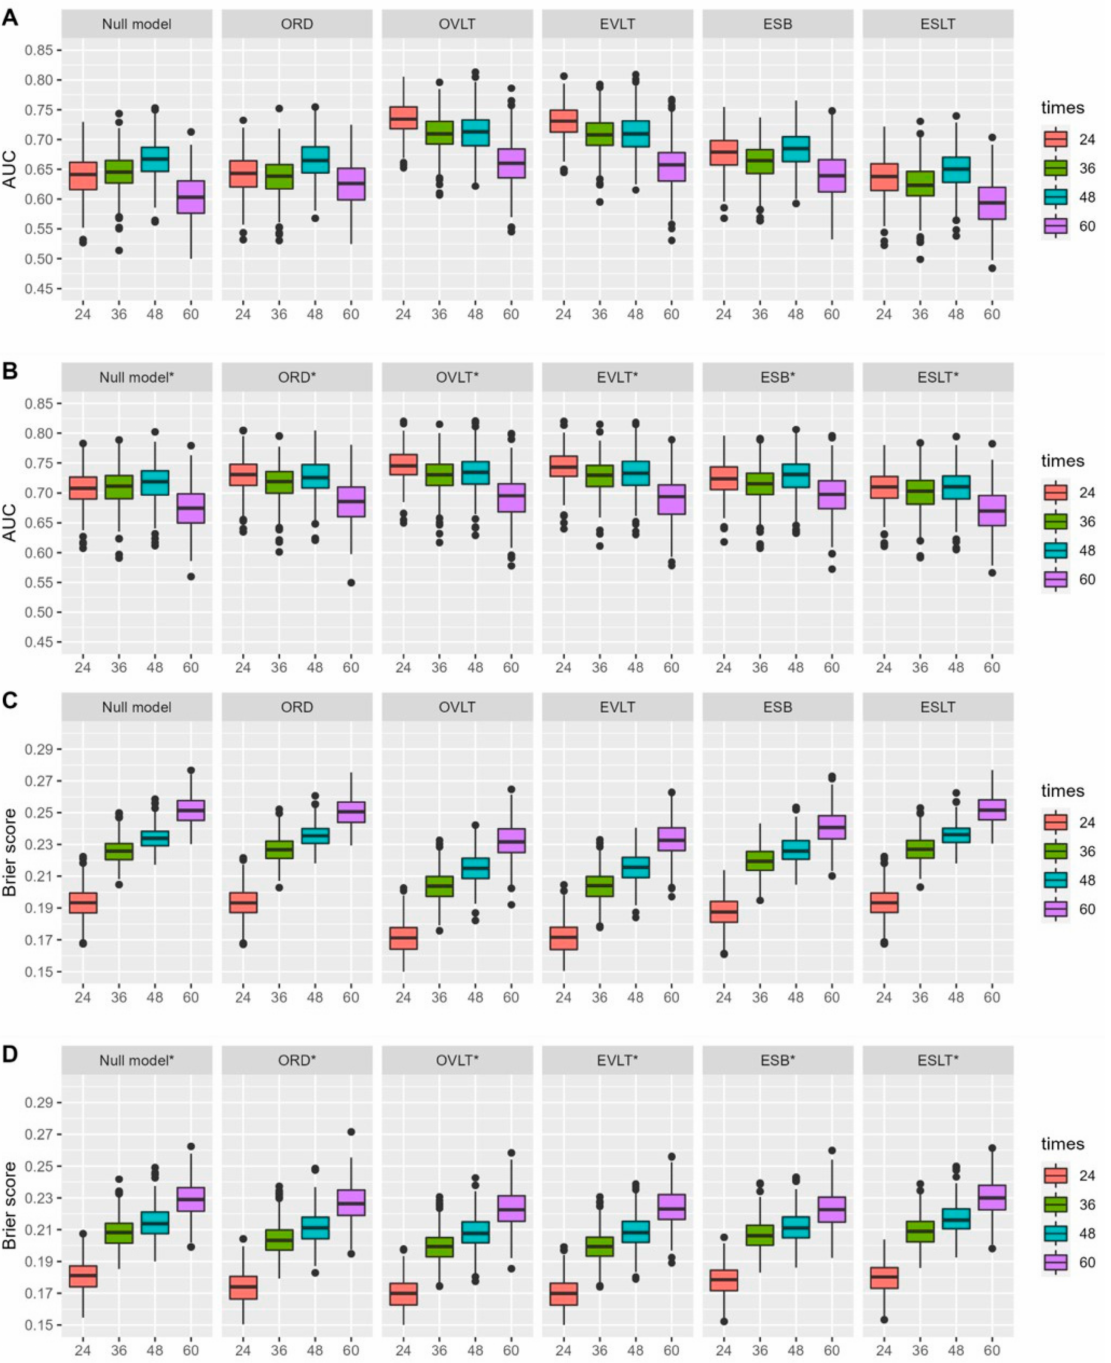
Figure 3. The 10-fold cross-validated AUCs ( A , B ) and Brier scores ( C , D ) for the prediction of overall survival at 24, 36, 48, and 60 months from CA-125 history up to 6 months, considering different CA- 125 summaries (ORD, OVLT, EVLT, ESB, ESLT) adjusted ( B , D ) or not ( A , C ) based on the CA-125 value at baseline. Null model: survival model stratified on study, ORD: observed relative decline, OVLT: observed value at landmark time. Null model: survival model stratified by study, ORD: observed relative decline, OVLT: observed value at landmark time, EVLT: estimated value at landmark time, ESB: estimated slope at baseline, ESLT: estimated slope at landmark time. * models adjusted for CA-125 at baseline. Note: The SCOTROC-1 trial was excluded for the landmark time at 6 months and prediction time at 36 months and for the landmark time at 3 months and prediction time at 48 months. The SCOTROC-4 and MITO-7 trials were excluded for both landmark times and for the prediction time of 60